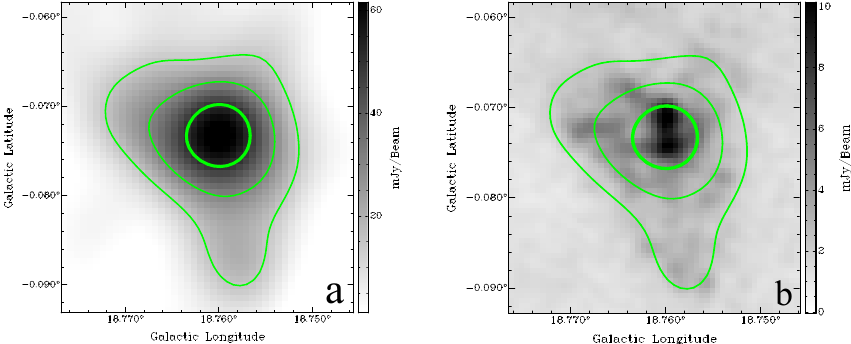
Figure 3. SNR G18.760-0.072 ( a ) THOR 1440 MHz; ( b ) MAGPIS 1.4 GHz image. The green contours are from the 1440 MHz THOR data at 15, 30, and 60 mJy/beam.